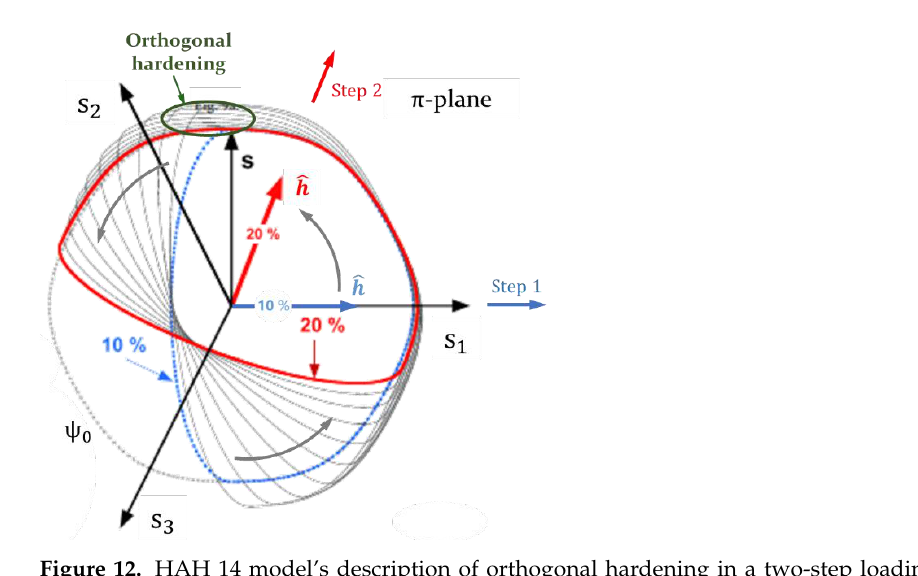
Figure 11. Evolution of the normalized yield surface in the Noman 10 model in the cases of ( a ) pro- portional loading and ( b ) continuous loading path changes . Reprinted with permission from Ref.